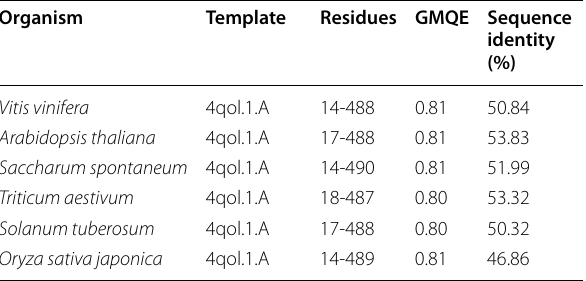
Table 6 Characterization of selected organism modeling from each cluster evaluated by SWISS-MODEL Organism